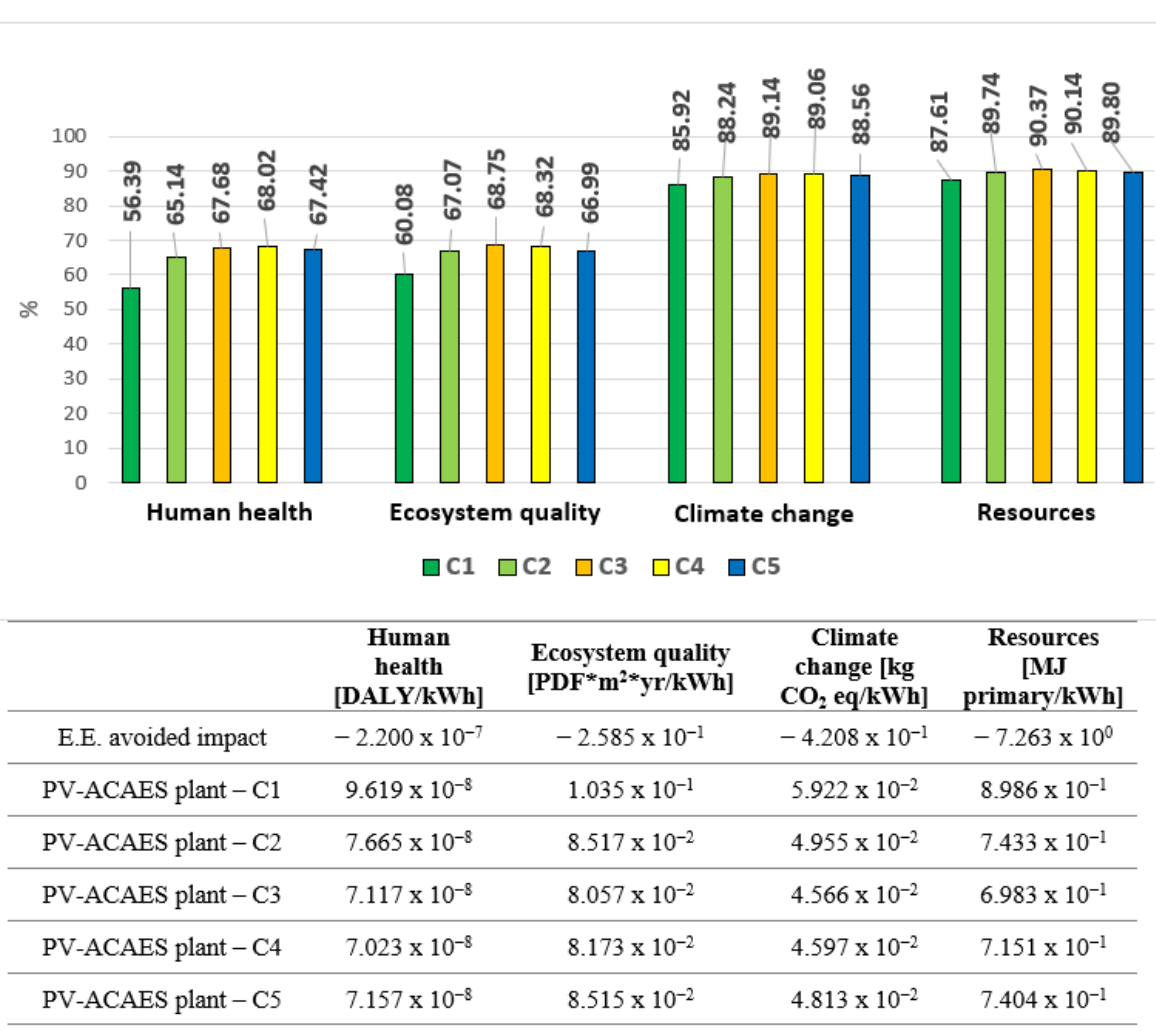
Figure 10. Impact category indicators for the PV-ACAES plants with air storage in a gas pipeline. The bar graph shows the impact reduction in comparison to the reference scenario.